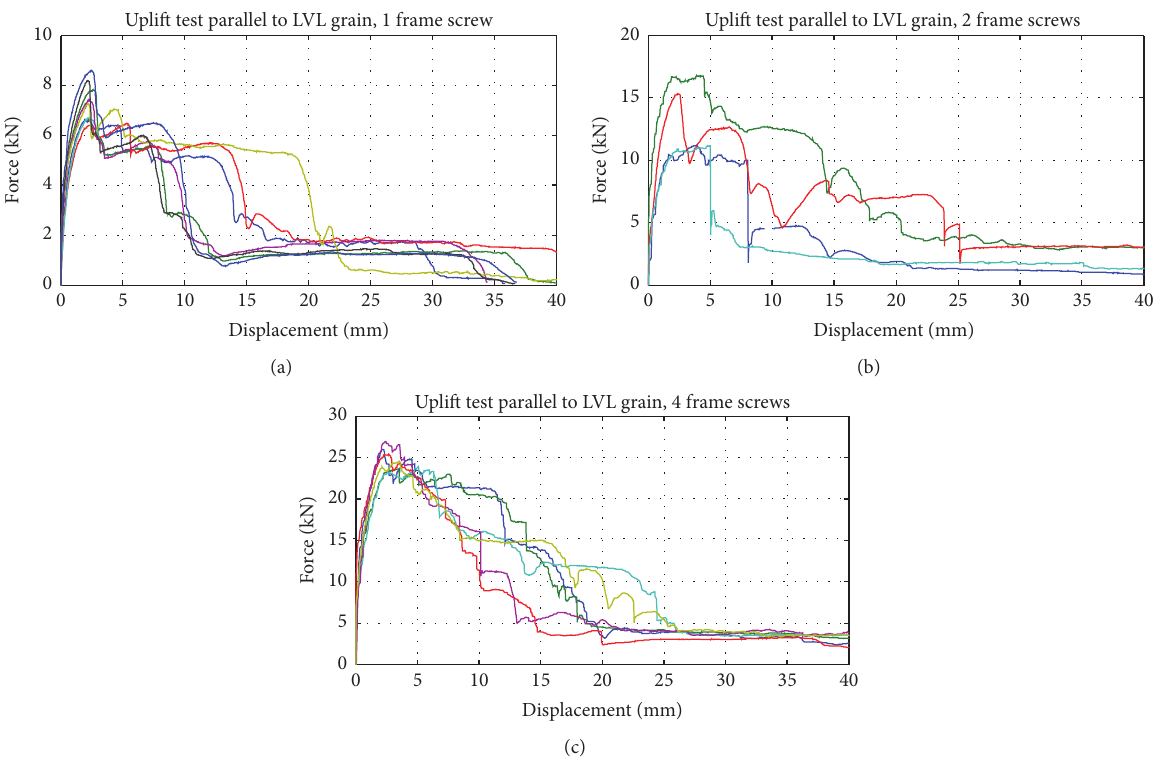
Figure 5: Load-displacement graphs for the uplift tests parallel to the LVL grain with (a) 1 screw, (b) 2 screws, and (c) 4 screws per connection.